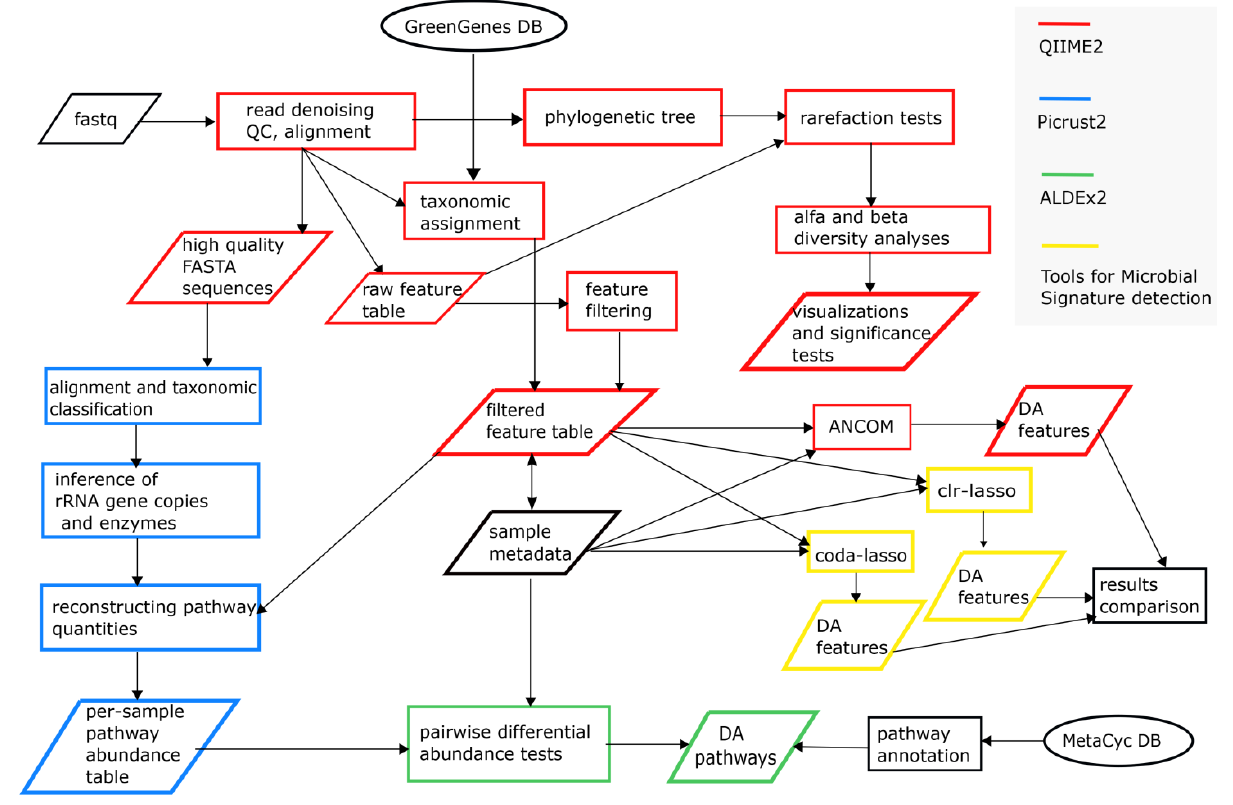
Figure 1. Analytical workflow of the study.